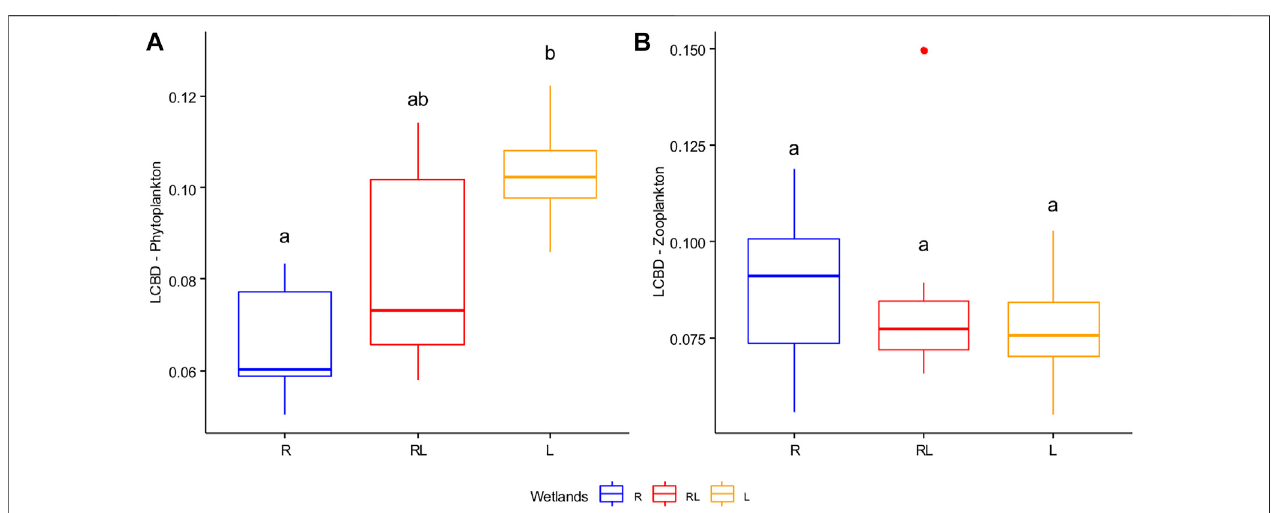
FIGURE 8 | Boxplot with the median (solid line) for Local Contribution to beta diversity (LCBD) values for phytoplankton data (A) and zooplankton data (B) in R = riverine papyrus swamps, RL = river mouth wetlands, and L = lacustrine wetlands. Data were combined for the dry and the wet season. Boxes that have no letter in common signi fi cantly differ from each